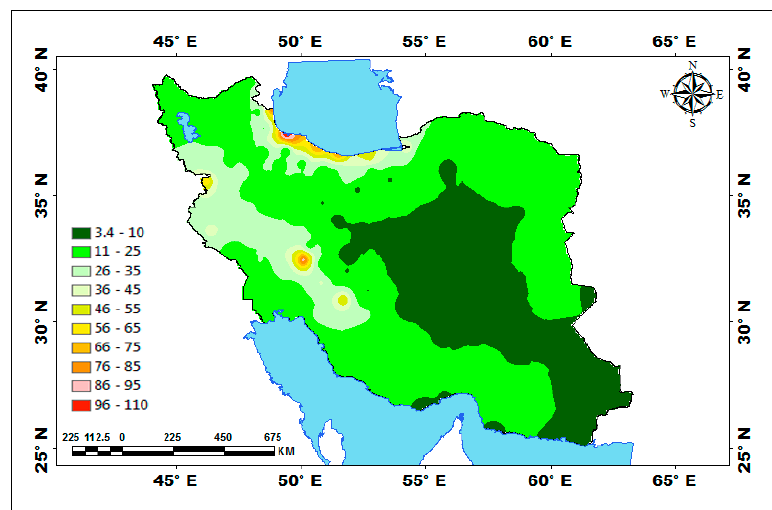
Figure 6. The coefficient of variations of Annual Rainfall (%).